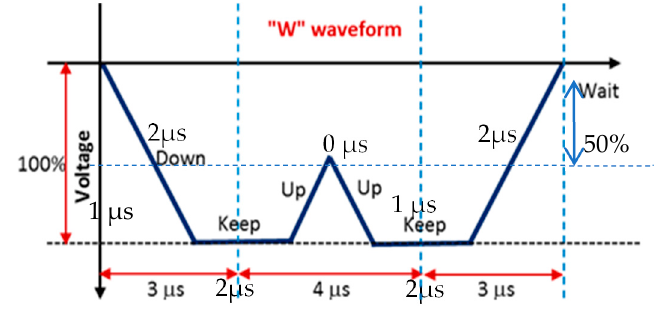
Figure 2. W preliminary vibration.